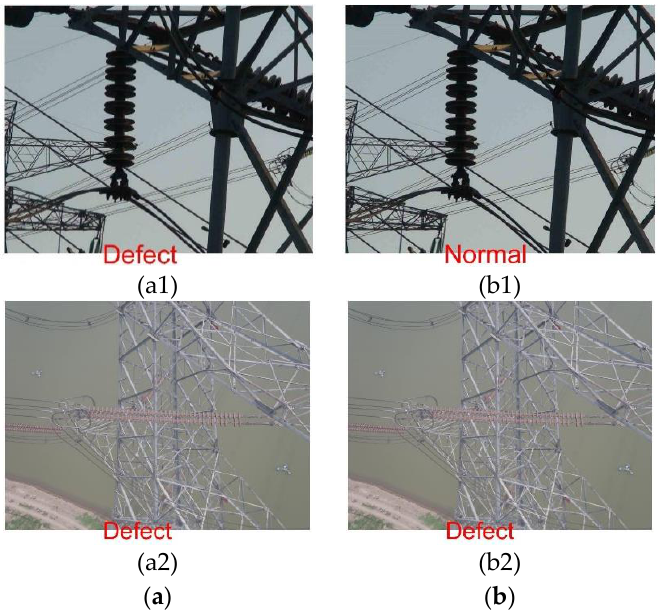
Figure 15. Classification results of each model test set: ( a ) CNN; ( b ) PSO-SVM.